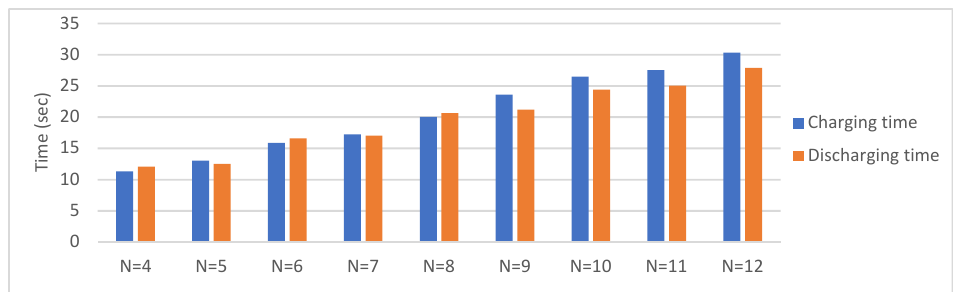
Figure 12. Comparison of times needed to charge the SC circuit from the initial voltage to the voltage at which switching to the next D 0 n is performed for different numbers of phases N .